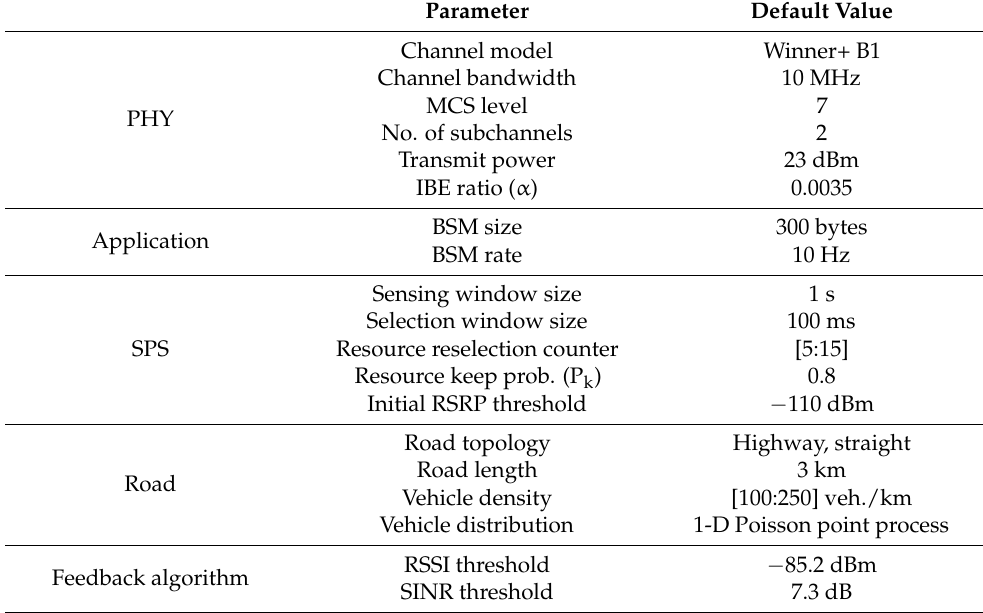
Table 2. Simulation parameters and their default